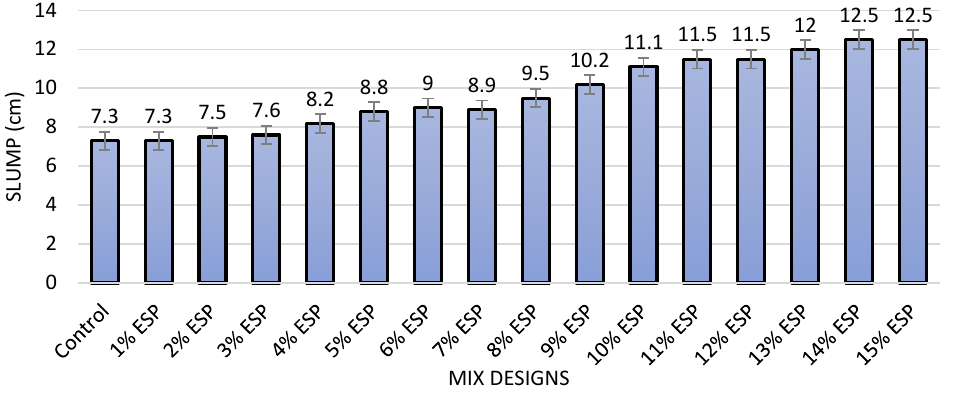
Figure 2. Slump results for all the mix designs.